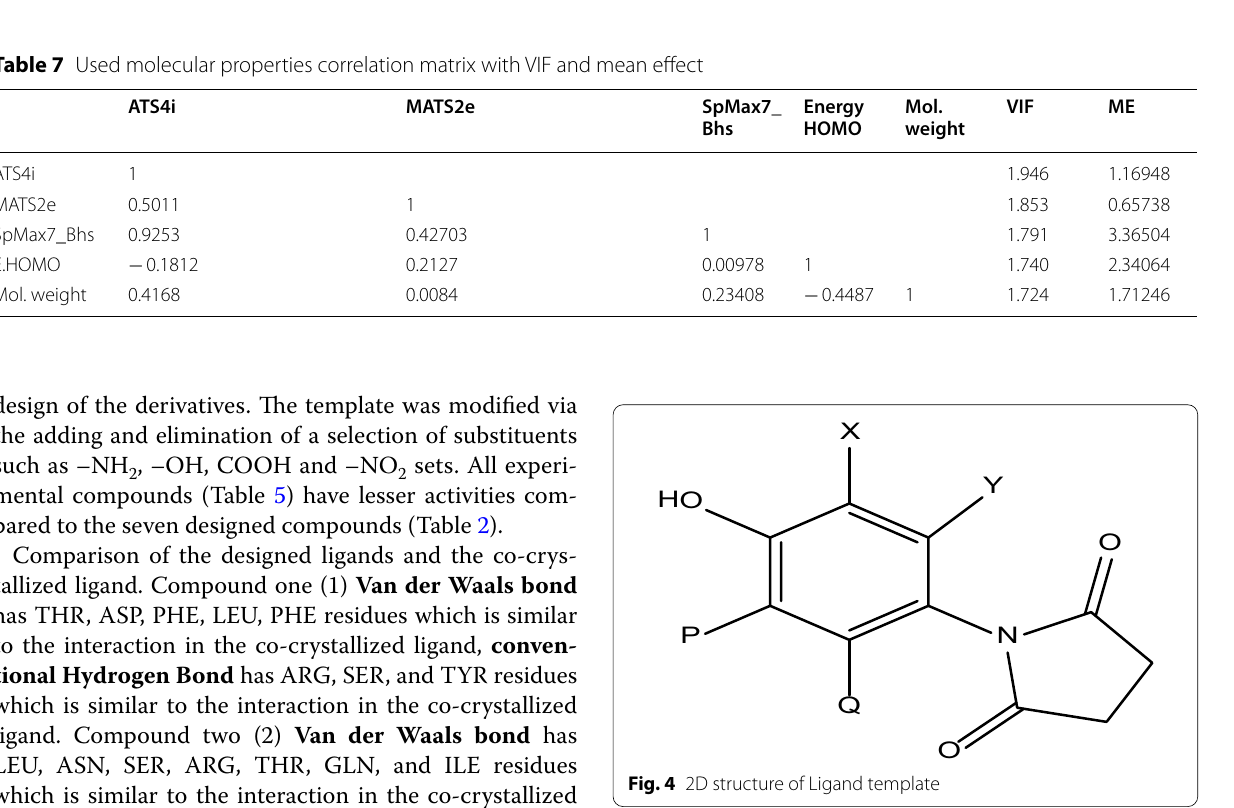
ARC average regression